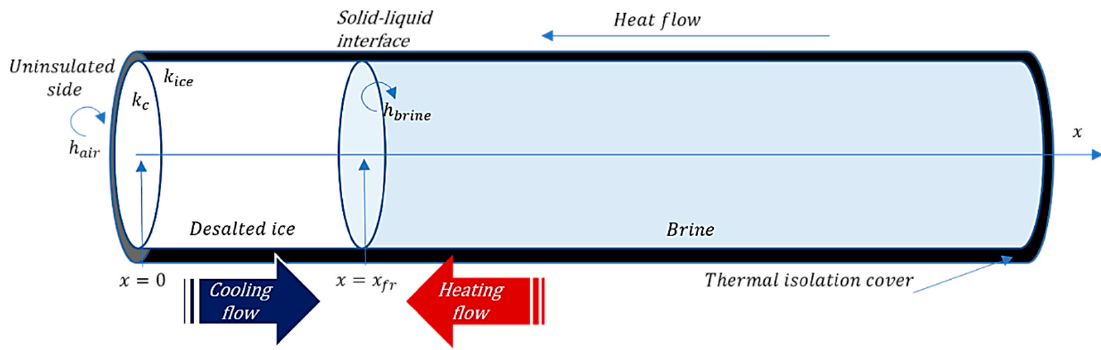
Figure 1. Scheme of the physical model.